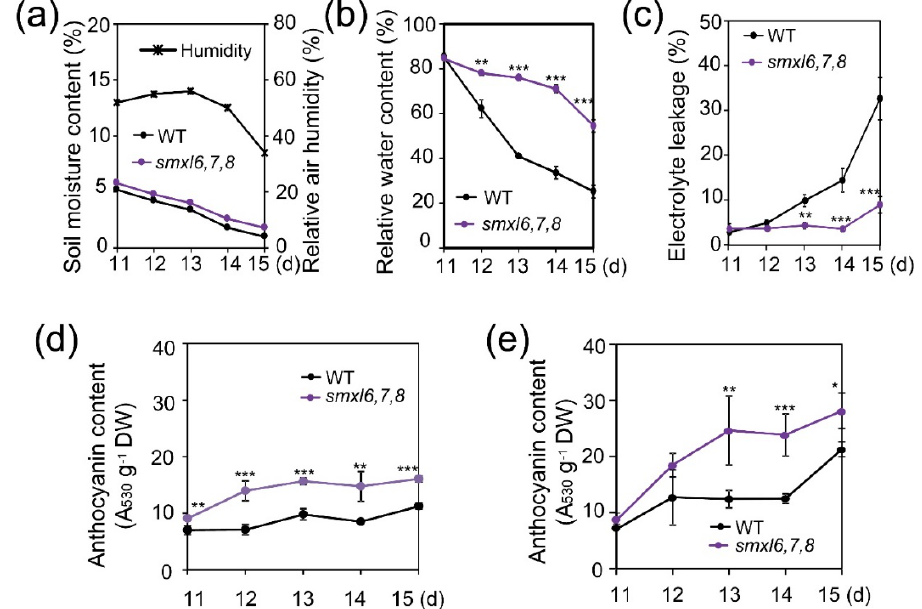
Figure 2. Relative water contents, electrolyte leakage percentages and anthocyanin contents obtained from smxl6 , 7 , 8 mutant and wild-type (WT) plants during the soil-drying experiment using the ‘same tray’ method. ( a ) Soil moisture content and relative air humidity during the soil-drying. ( b , c ) Relative water contents ( b ) and electrolyte leakage percentages ( c ) of the two genotypes during the soil-drying. ( d , e ) Anthocyanin contents in the two genotypes under well-watered ( d ) and progressive soil-drying ( e ). Data are means and SEs ( n = 4 plants / genotype). Asterisks show significant di ff erences between the smxl6 , 7 , 8 mutant and WT plants at each time point (Student’s t -test; * p < 0.05, ** p < 0.01 and *** p <